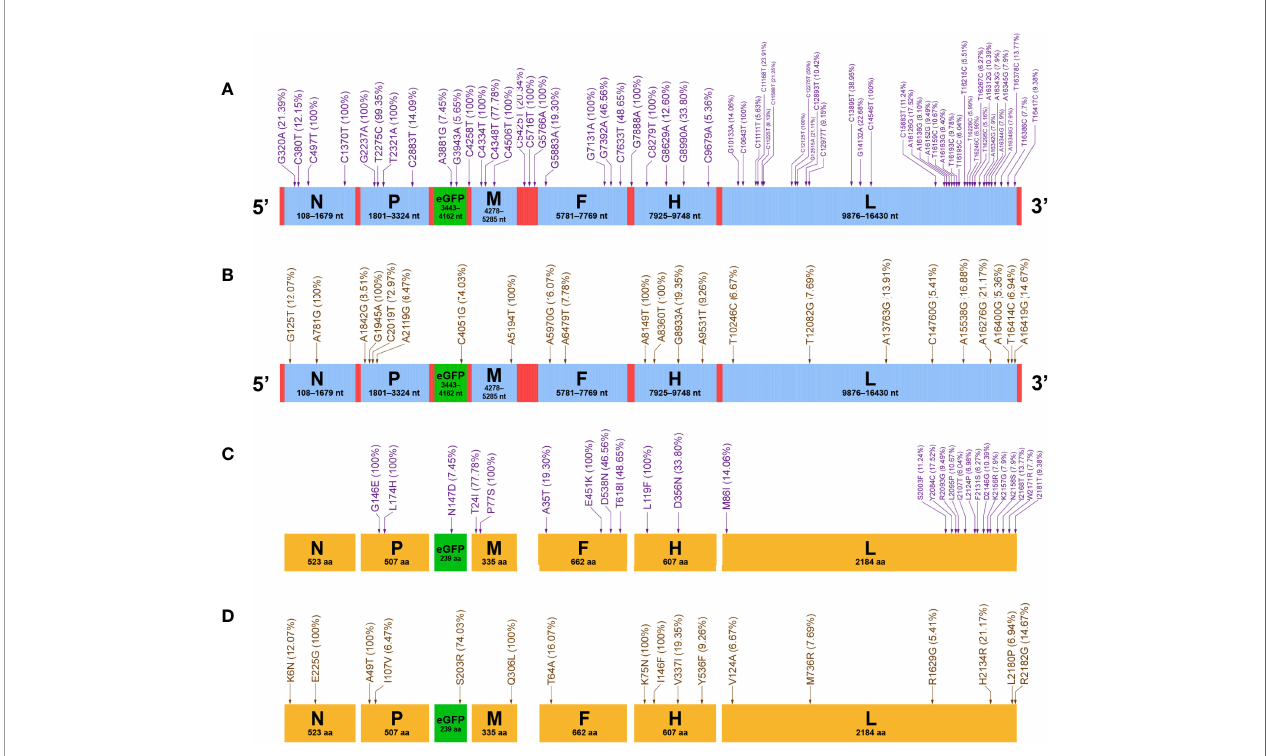
FIGURE 4 | Mutation pro fi les of rCDV-eGFP-R and -N at P47. Distributions of SNMs in rCDV-eGFP-R (A) and -N (B) antigenomes. Distributions of SAAMs in rCDV- eGFP-R (C) and -N (D) proteins. All UTRs and ORFs proportionally match their actual lengths in viral antigenome. All 7 proteins proportionally match their actual lengths. Arrows indicate mutation sites that do not exactly match their de fi nite positions in antigenomes or in proteins. Mutation frequencies are enclosed within